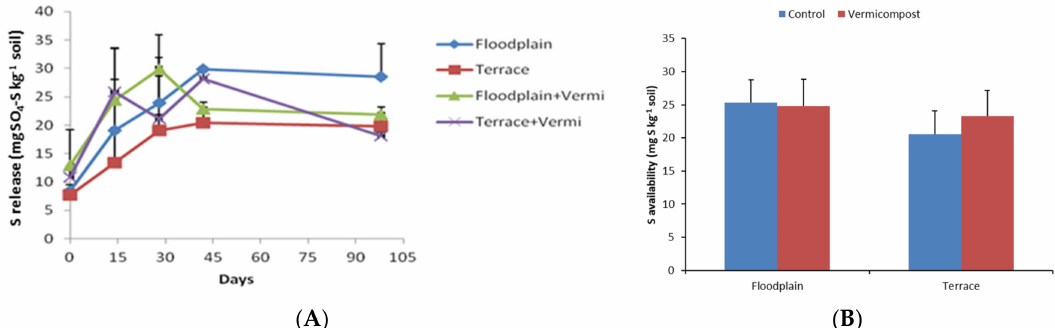
Figure 4. Trend of SO 42- -S release pattern from vermicompost-amended soils during incubation study for a period of 14 weeks ( A ); S release in two contrasting soils after 98 days ( B ) as influenced by vermicompost amendment.